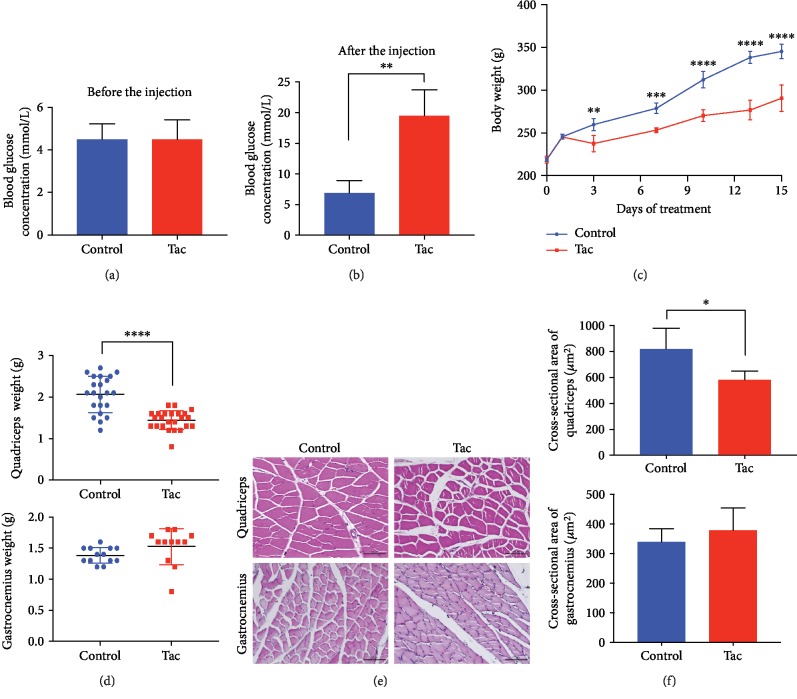
Skeletal muscle atrophy in rats with posttransplantation diabetes mellitus (PTDM). Blood glucose concentrations before and after the injection (a, b). Body weight of the rats (c). Wet weight of quadriceps and gastrocnemius (d). Cross-section area of quadriceps and gastrocnemius stained with hematoxylin and eosin (e). The data of cross-section area (f). Scale bars represent 50 μm. Data are means ± SD. ∗p < 0.05, ∗∗p < 0.01, ∗∗∗∗p < 0.0001.